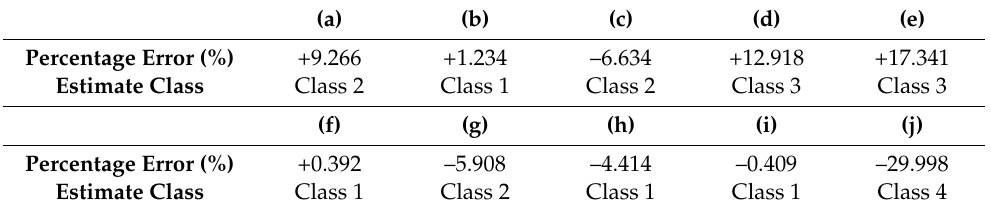
Table 8. Evaluation of AACE conformity of parametric prediction model in planning stage.